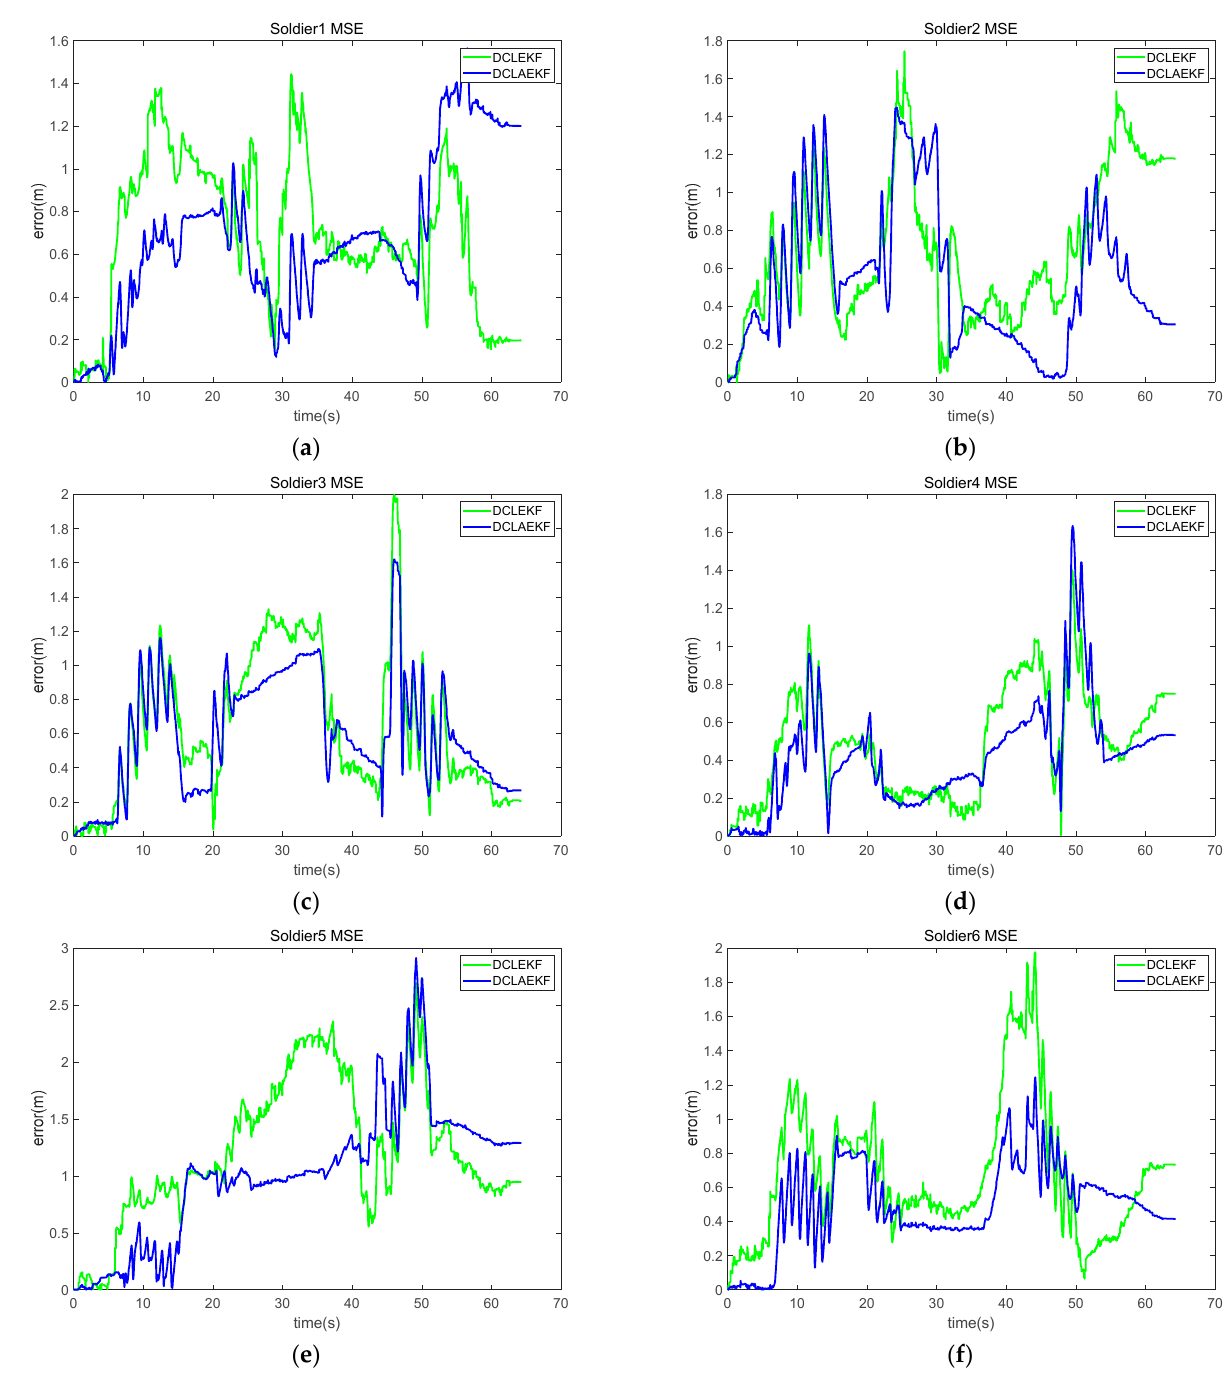
Figure 8. MSE curves of soldiers in a building environment experiment. ( a ) MSE of soldier 1; ( b ) MSE of soldier 2; ( c ) MSE of soldier 3; ( d ) MSE of soldier 4; ( e ) MSE of soldier 5; ( f ) MSE of soldier 6. The localization results and MSE curves in the figures indicate that the DCLAEKF algorithm displayed higher errors than the DCLEKF algorithm at some times but demonstrated lower errors most of the time. This was due to the complexity of the indoor environment, limited space, and the presence of various types of obstructions, such as walls, desks, chairs, doors, and windows. The sole use of the differential method, as described in Section 2.2, could lead to inaccurate NLOS detection, thereby limiting the effectiveness of adaptive algorithms. The MSEs in Table 2 indicate that the DCLAEKF algorithm achieved